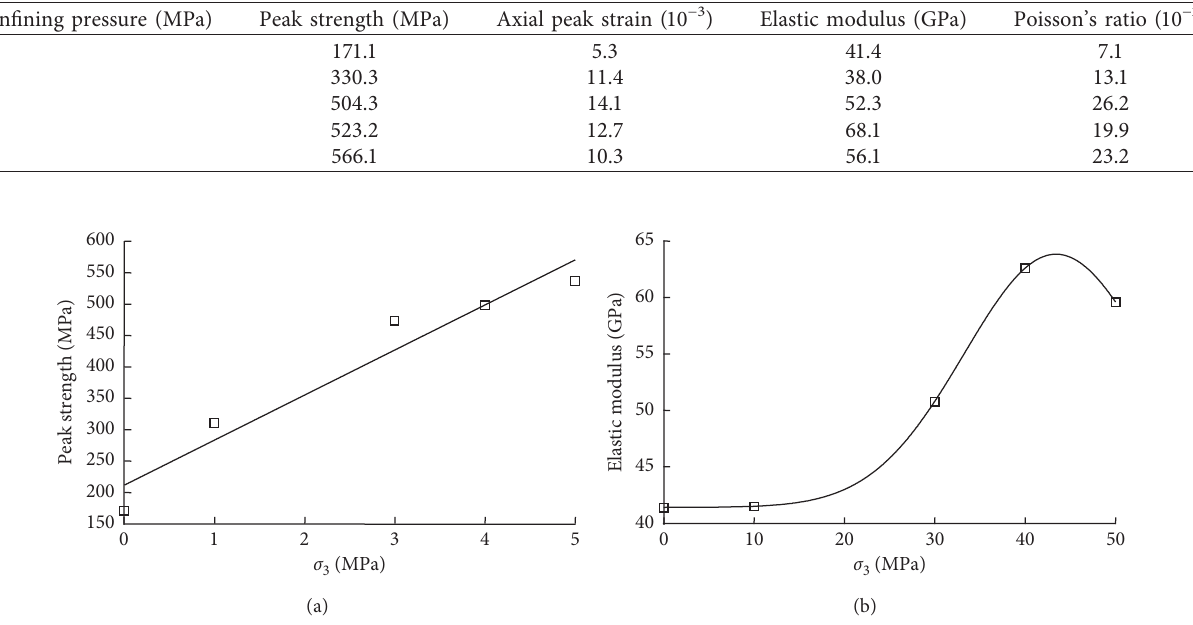
Figure 4: Relationship between peak strength, elastic strength, Poisson’s ratio, and confining pressure in conventional triaxial tests. (a) Peak strength vs. confining pressure. (b) Elastic modulus vs. confining pressure.